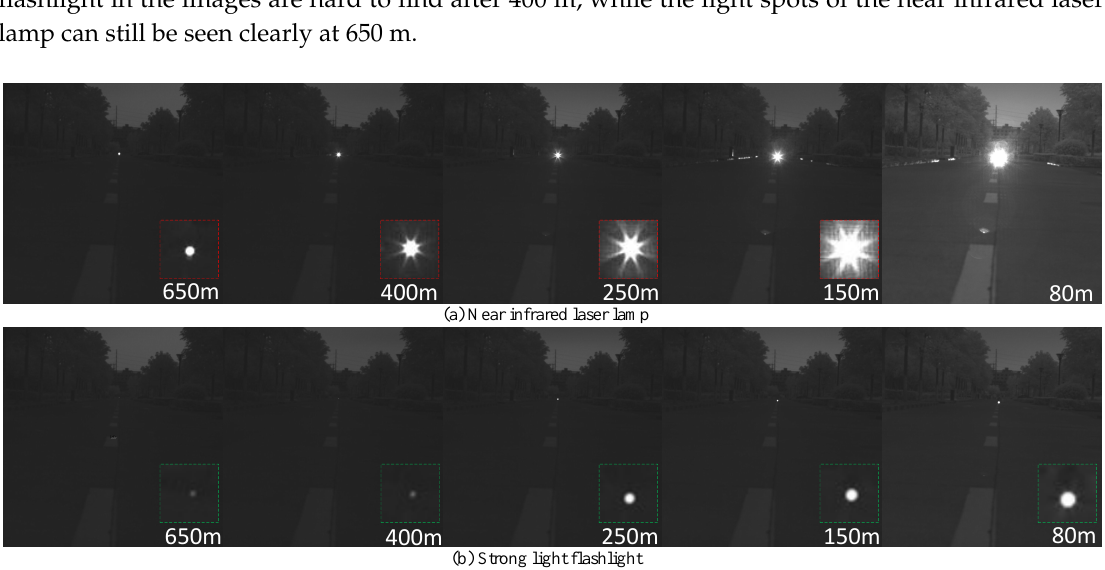
Figure 5. The comparison of the imaging at different